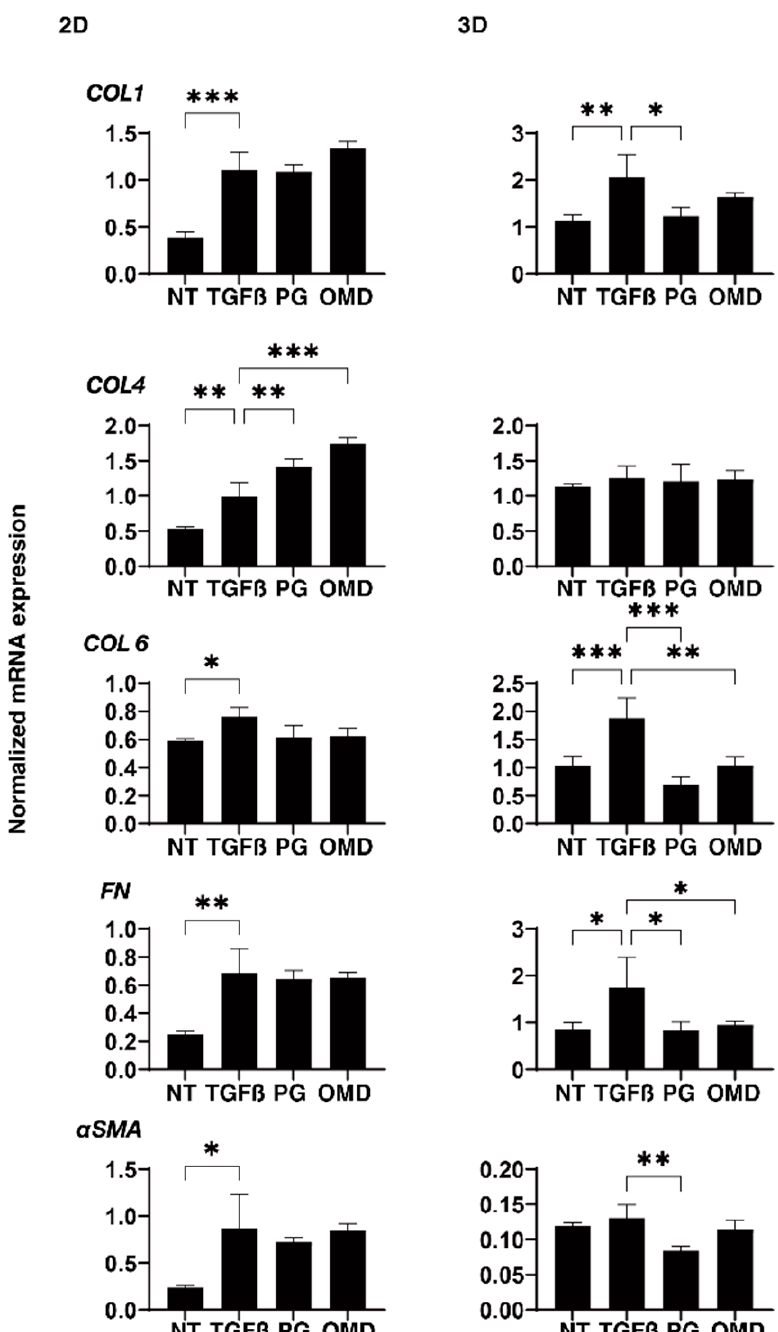
Figure 4. Effects of PGF2 α and the EP2 agonist, omidenepag (OMD), on the mRNA expression of ECM proteins in 2D- and 3D-cultured HTM cells. At Day 6, HTM 2D cells and 3D spheroids (NT: non-treated control) and those treated with a 5 ng/mL solution of TGF- β 2 (TGF β ) in the absence and presence of 100 nM PGF2 α (PG) or the EP2 agonist, omidenepag (OMD) were subjected to qPCR analysis to estimate the expression of mRNA in ECMs (COL1, COL4, COL6, FN and α SMA). Analyses were performed in triplicate using fresh preparations ( n = 12–15 3D spheroids each). “+” is reagents addition. Data presented are the arithmetic mean ± standard error of the mean (SEM), and statistical differences were determined by ANOVA followed by a Tukey’s multiple comparison test. * p < 0.05, ** p < 0.01, *** p <